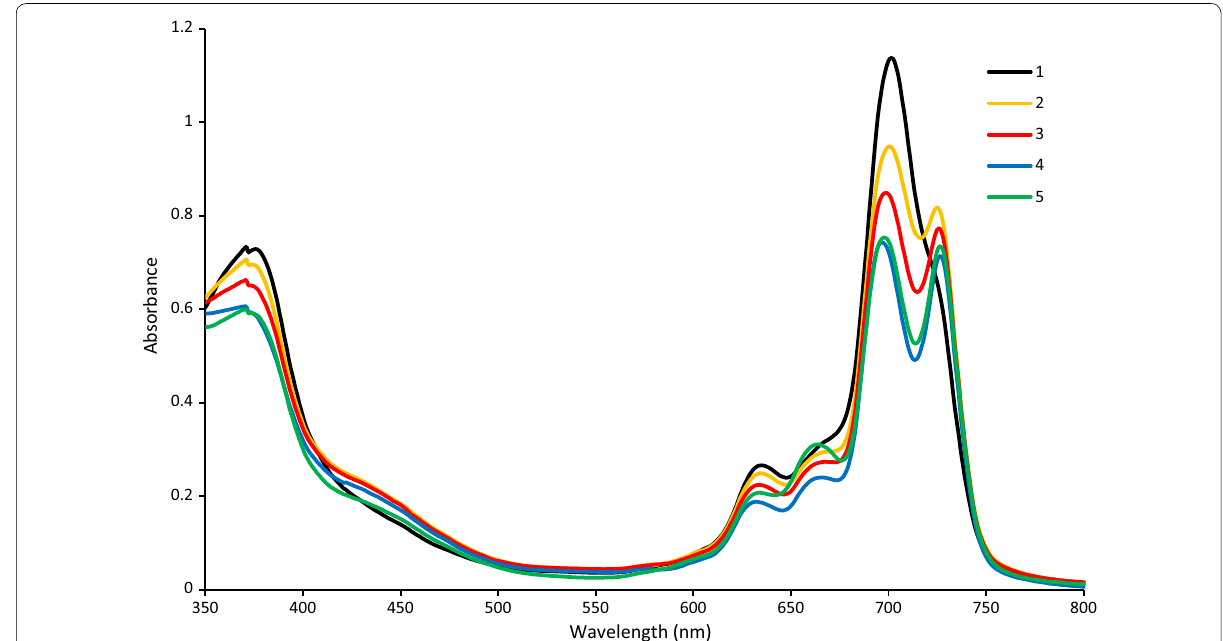
Fig. 6 UV–vis spectra of GdPc-thiof in toluene at 20 mg l − 1 upon addition of acetic acid (AcOH). 1 : without AcOH; 2 : addition of 5 μl AcOH, reaction time 5 min; 3 : as 2 , but after 30 min; 4 : as 2 , but after 1 h, 5 : as 4 —addition of 10 μl Et 3 N